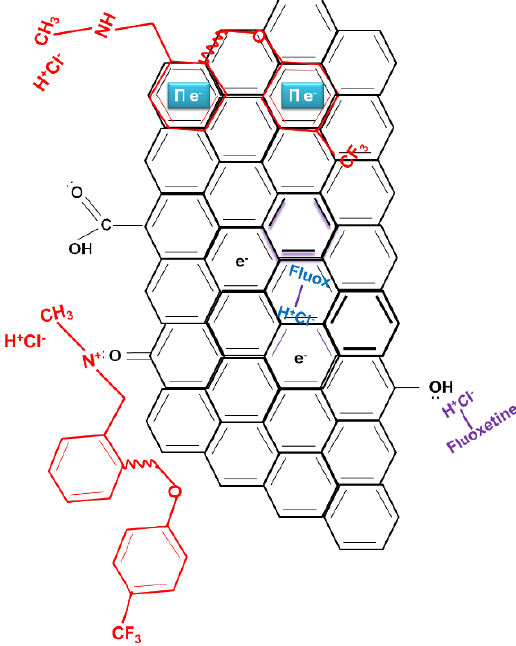
Figure 2. Mechanisms of adsorption of fluoxetine onto activated hydrochars.